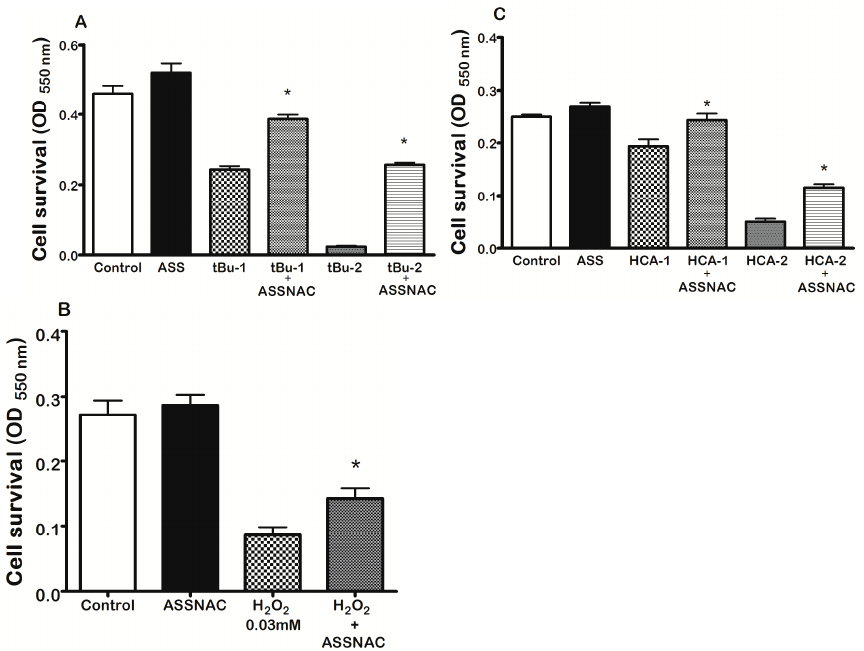
Figure 5. Protective effect of ASSNAC from oxidative stress in ARPE-19 cells. Confluent ARPE-19 cells were pretreated without or with ASSNAC (0.2 mM; ASS) for 24 h, washed and further incubated in medium containing 1% serum without (control) or with ASSNAC (0.2 mM), respectively and exposed to the following oxidants: ( A ) tert-butyl hydroperoxide ( t -BuOOH) ( t Bu-1 at 0.05 mM and t Bu-2 at 0.10 mM) for 24 h. ( B ) H 2 O 2 (0.03 mM) for 1 h. ( C ) Homocyesteine (HCA-1 at 7.5 mM and HCA-2 at 10.0 mM) for 24 h. Cultures were washed and stained with neutral red to determine cell survival. Survival of the ASSNAC-treated groups was significantly higher than that of the non-treated group (* p ≤